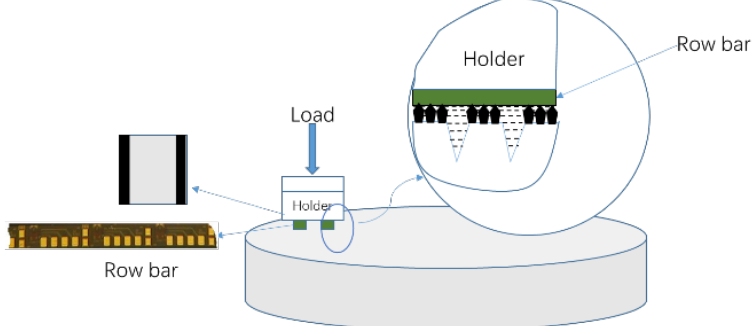
Figure 5. Schematic of the grinding